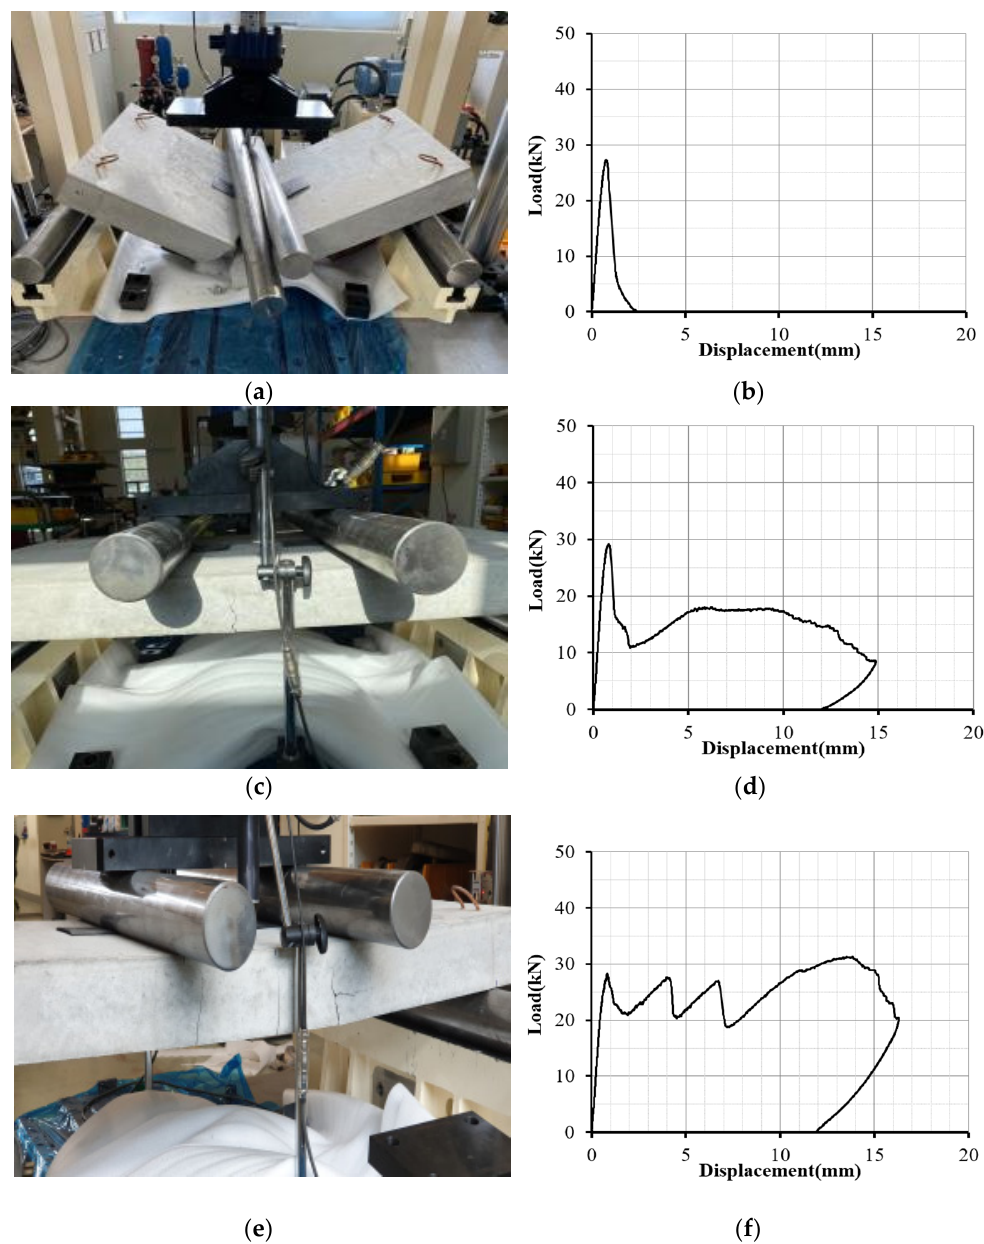
Figure 5. Results of flexural strength experiment. ( a ) Flexural strength. ( b ) Flexural strength ratio.